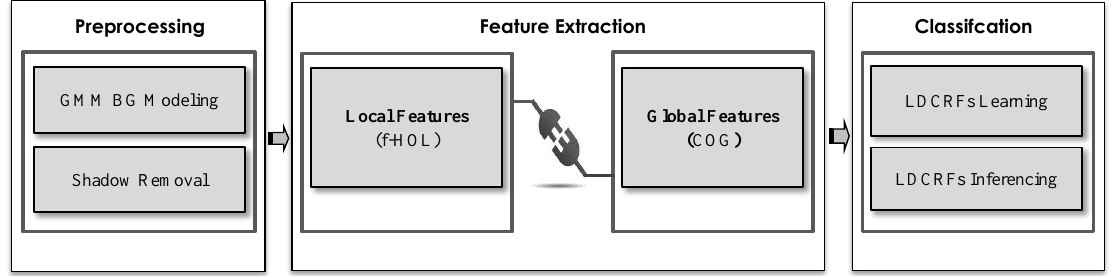
Figure 1. A schematic diagram of the proposed methodology for action